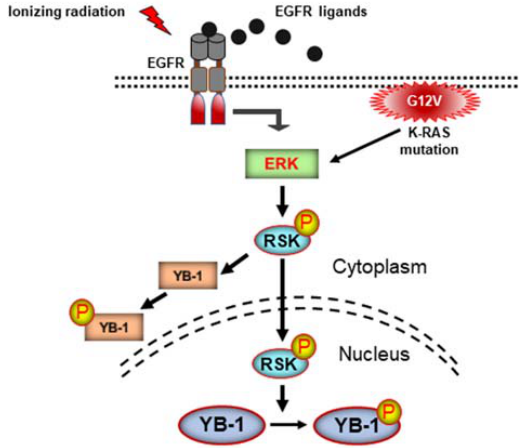
Figure 5. Schematic representation of the signaling cascade involved in Ser-102 phosphorylation of nuclear YB-1. Arrows indicate transition of YB-1 activating signals from the upstream stimulators.